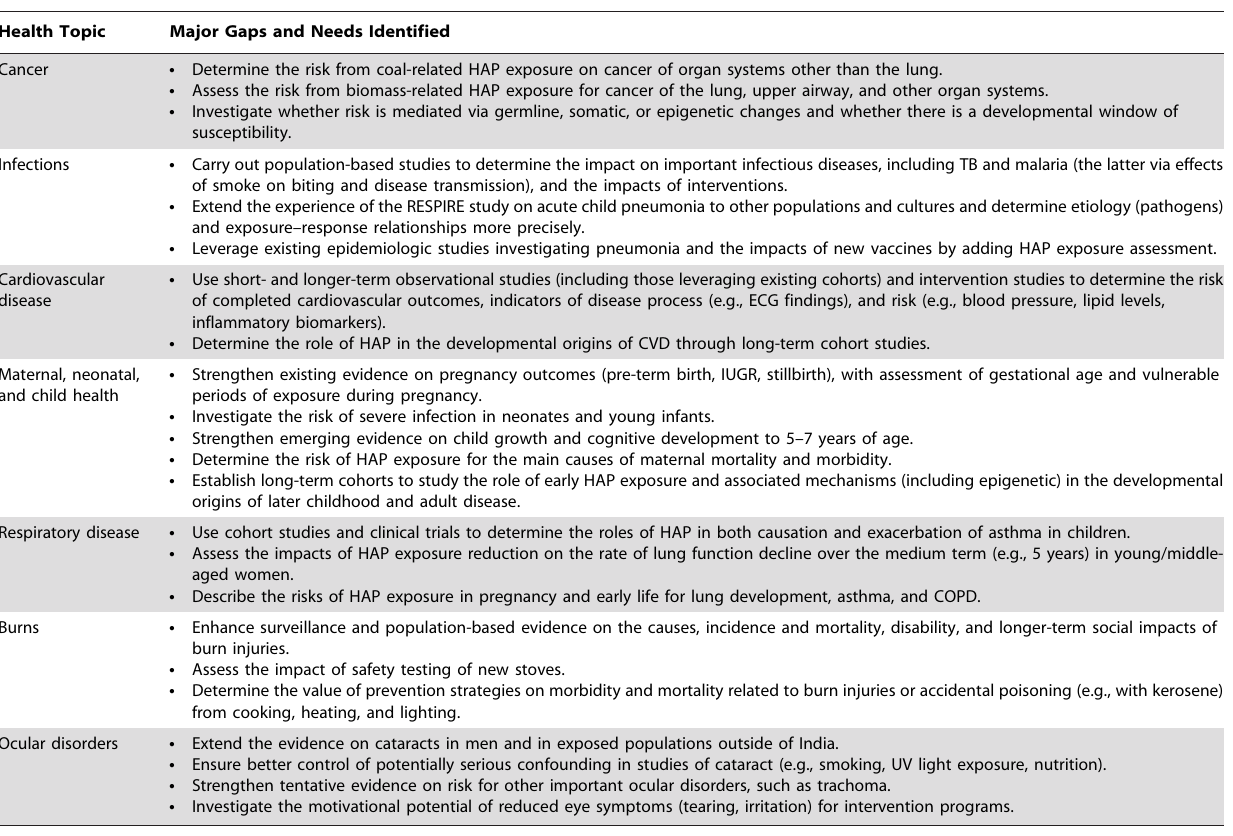
Table 1. Summary of major research gaps and needs for evidence on health outcomes.